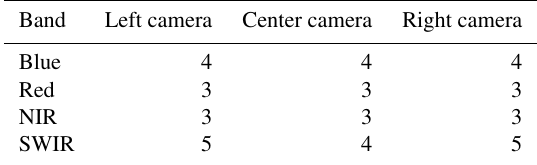
Table 2. PROBA-V instrument noise (%).